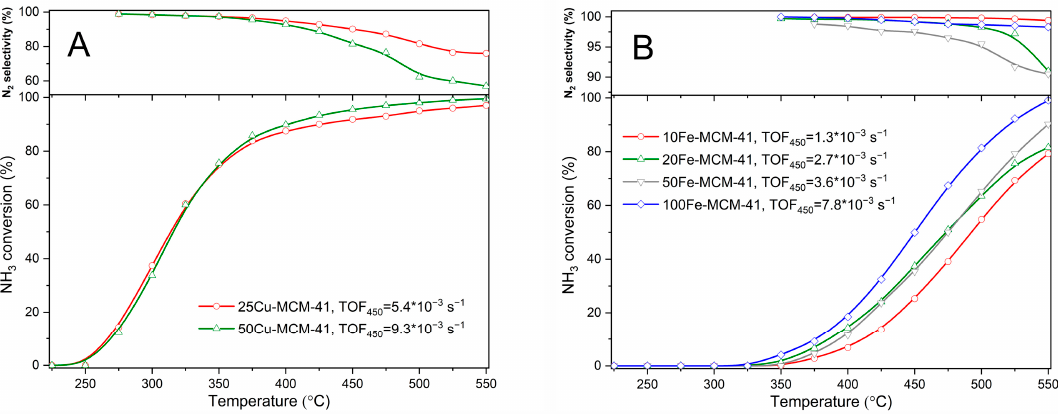
Figure 10. Temperature dependence of NH 3 conversion and N 2 selectivity in SCO of NH 3 for spherical MCM-41 modified with copper ( A ) and iron ( B